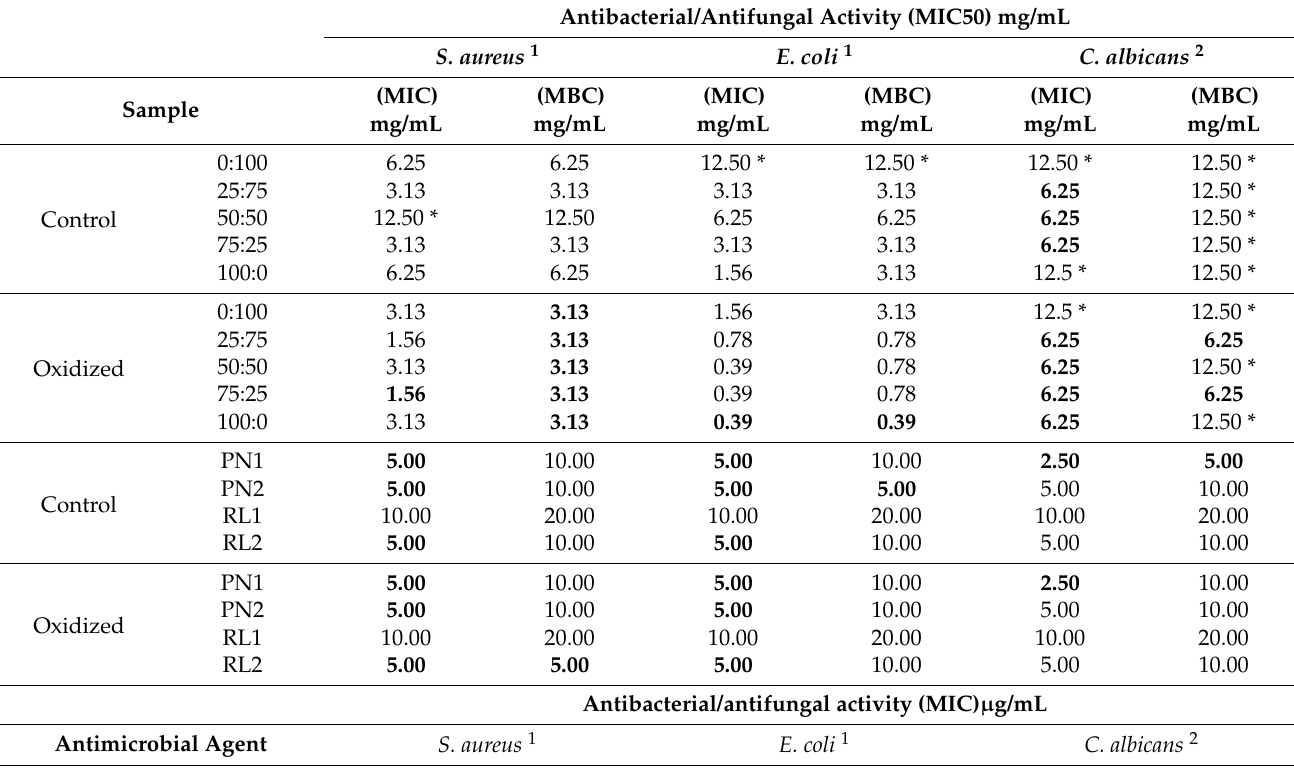
Table 6. Minimum inhibitory concentration (MIC) and minimum bactericidal concentration (MBC) values of oxidized and non-oxidized (control) flavonoid model (Cat:GST at 0:100, 25:75, 50:50, 75:25 and 100:0 ratios) and Pinot noir (PN1 and PN2) and Riesling (RL1 and RL2) wine lees. Antibacterial/Antifungal Activity (MIC50)